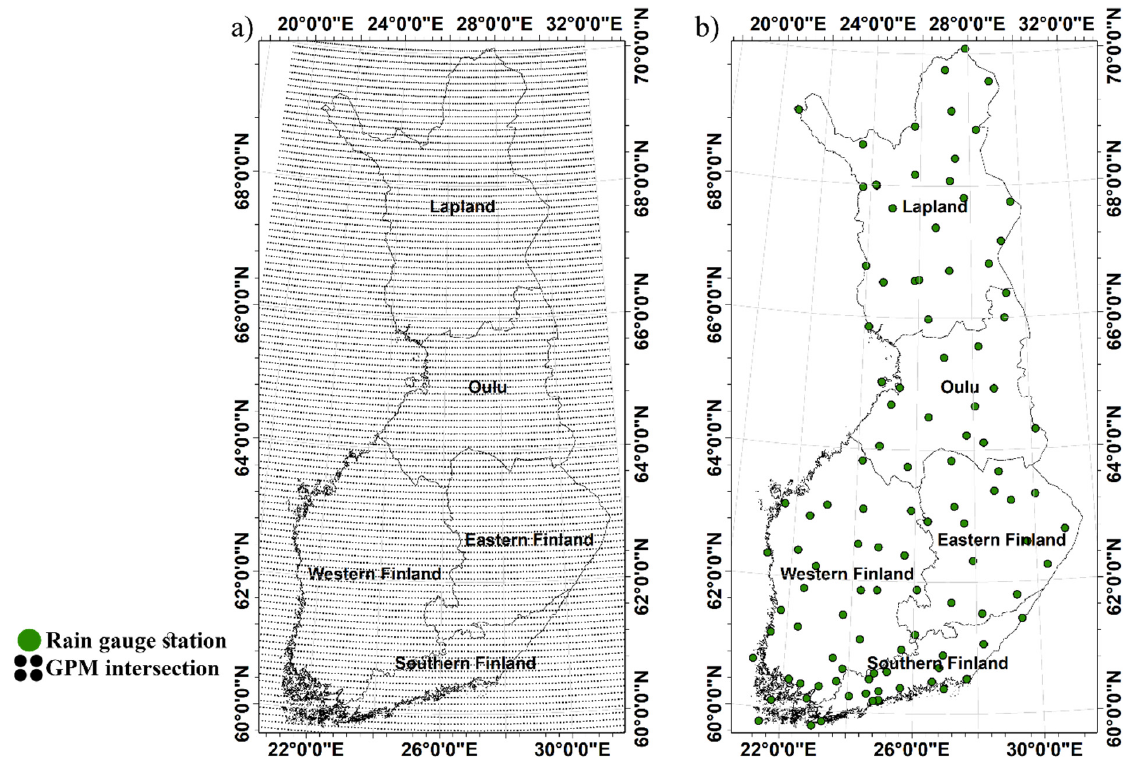
Figure 2. ( a ) GPM satellite intersections/grids over Finland. ( b ) Finland historical districts and distribution of FMI rain-gauge stations.